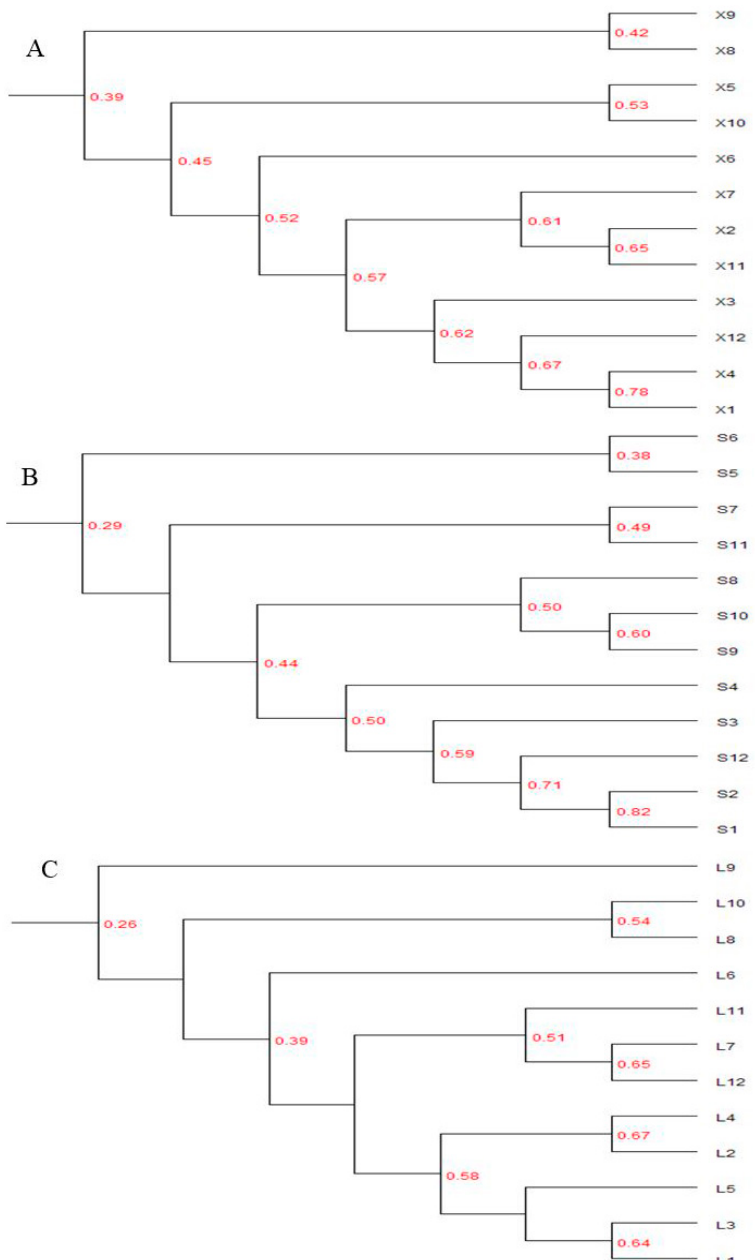
Figure 7. Dendrogram obtained by unweighted pair group with mathematical averages (UPGMA) clustering of DGGE patterns from three reservoirs. Similarity is expressed as the Dice correlation coefficient. ( A ) Xi-keng (X) Reservoir; ( B ) Shi-yan (S) Reservoir; ( C ) Luo-tian (L) Reservoir.